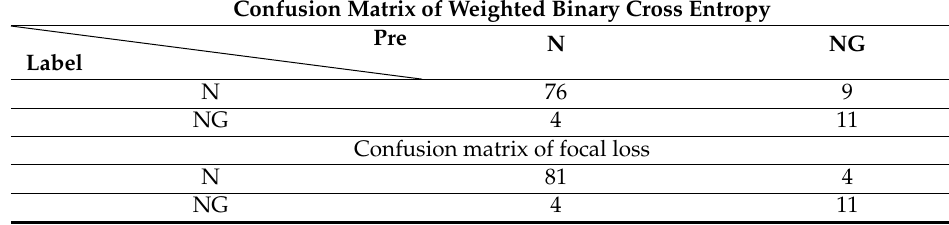
Table 5. Confusion matrix of DNN.